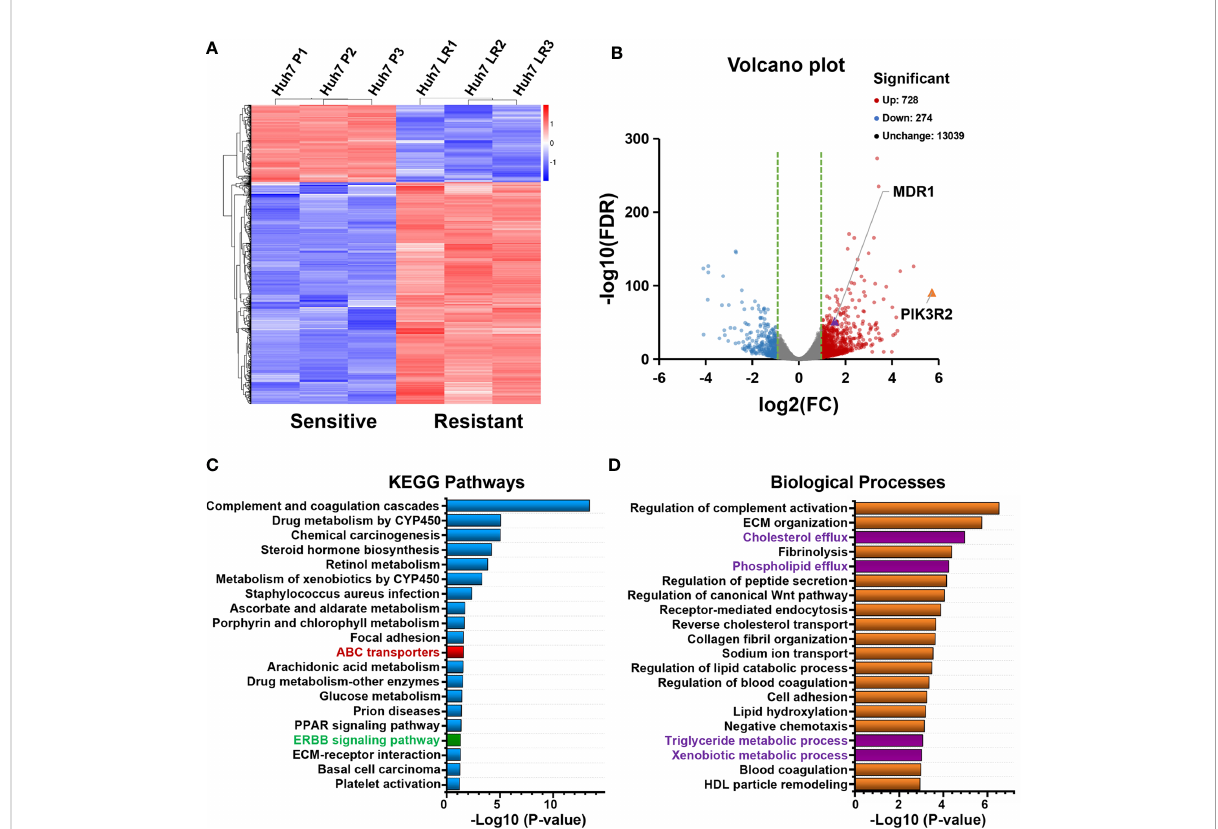
FIGURE 2 Transcriptomic analysis of Huh7 P and Huh7 LR cells based on RNA sequencing (three samples for each group). (A, B) Clustering heatmap and volcano plot show differentially expressed genes between the Huh7 P and Huh7 LR cell lines (> 2-fold change, p < 0.001). (C, D) KEGG pathways and biological processes associated with signi fi cantly upregulated genes in Huh7 LR cells (> 2-fold change, p <